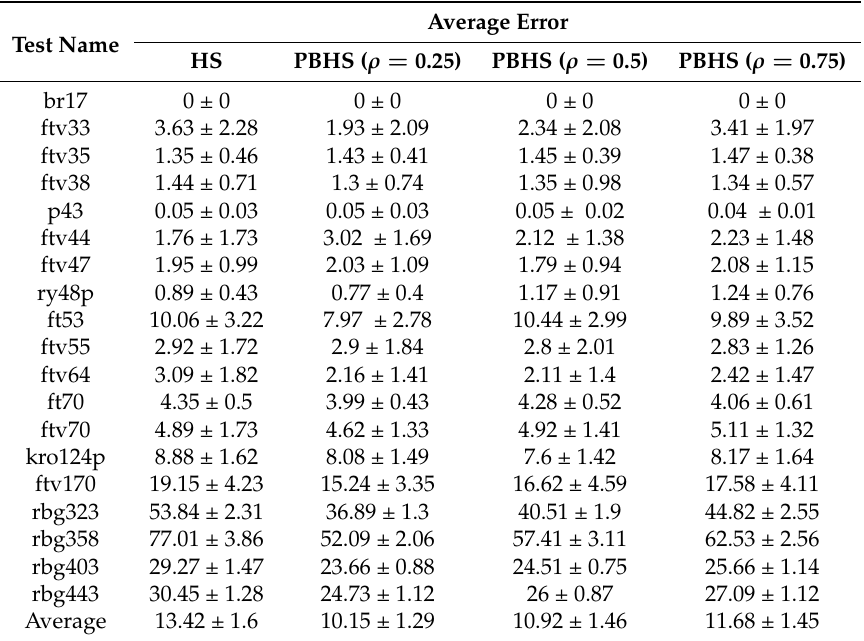
Table 2. Comparison of the average